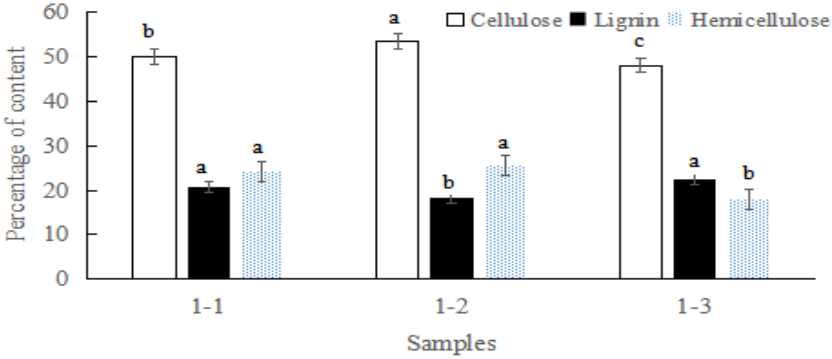
Figure 1. Contents of cellulose, lignin, and hemicellulose of E. grandis . 1 – 1 represented the DBH of the trunk. 1 – 2 represented the middle part of the trunk. 1 – 3 represented the upper part of the trunk. Different lowercase letters in the table represent significant differences at 0.05 level.